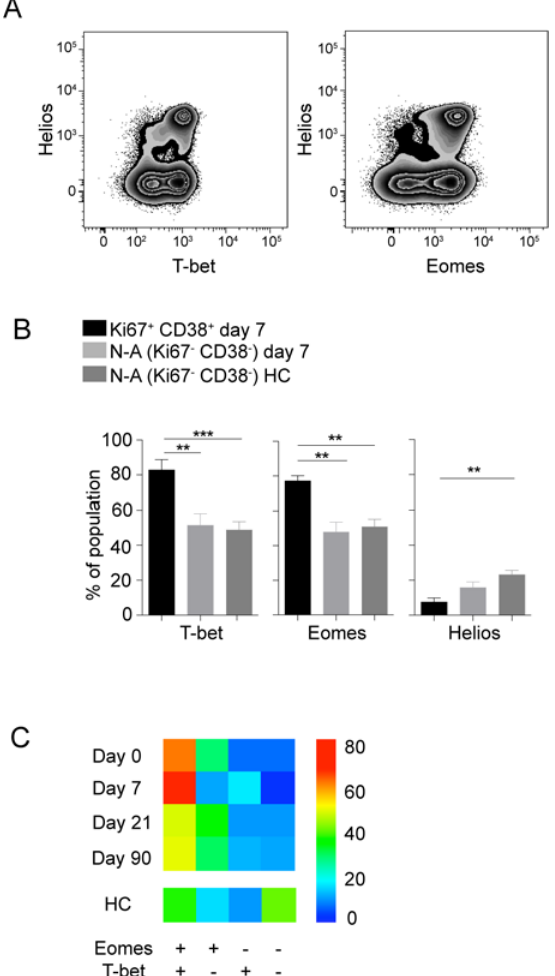
Figure 2. Transcriptional profile of activated CD8 T cells. (A) Flow plots show Helios, T-bet and Eomes stainings in CD8 T cells from one representative donor. (B) Bar plots show the 10 – 90th percentiles of T-bet, Eomes and Helios expression in the CD38 and Ki67 co-expressing CD8 T cell subset at day 7 after hospitalization (n = 10), and at day 7 after hospitalization in non-activated cells or in non-activated healthy controls (n = 16). (C) Heat map represents subset distribution of Eomes and T-bet within the CD38 and Ki67 co-expressing CD8 T cells (n = 10). Statistical analysis was performed using the Mann-Whitney test. * , p < 0.05; ** , p < 0.01; *** , p <